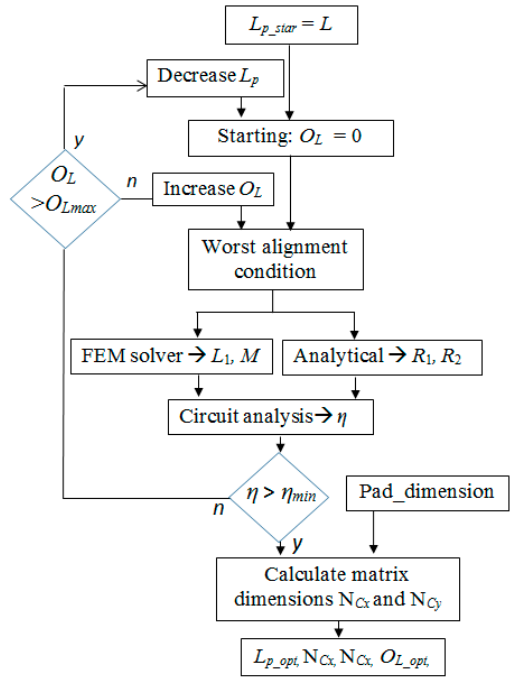
Figure 8. Flow chart of the coil design procedure.